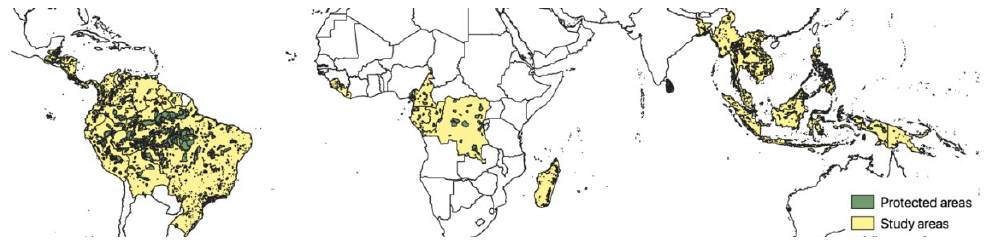
Figure 1. 34 Tropical countries and protected areas analyzed in this study.